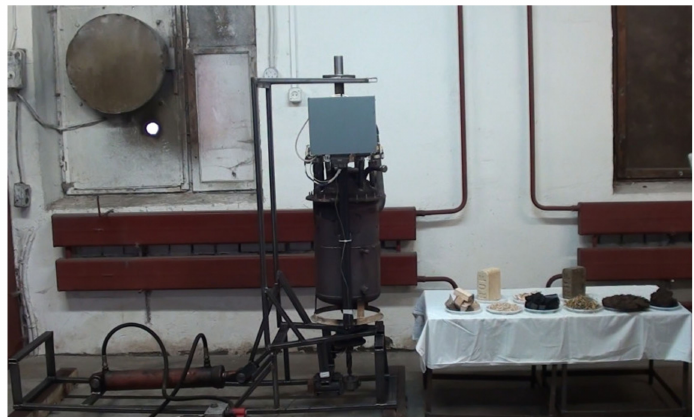
Figure 4. General gas generator image picture.